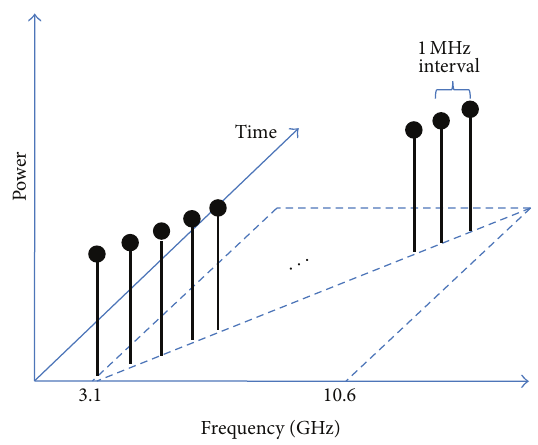
Figure 2: The proposed UWB signal for MIMO radar angle esti-